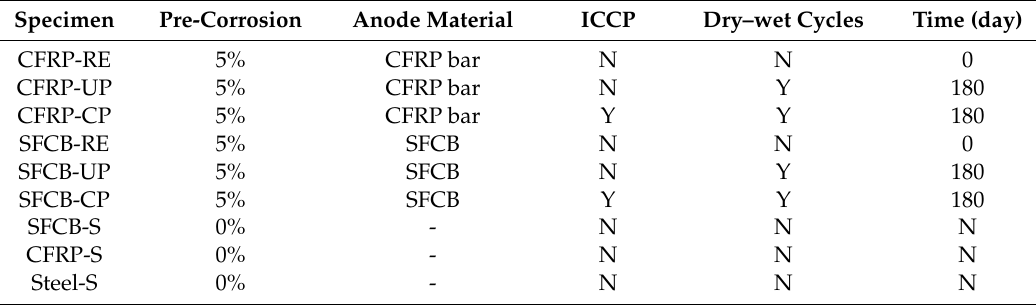
Table 1. Experimental design.